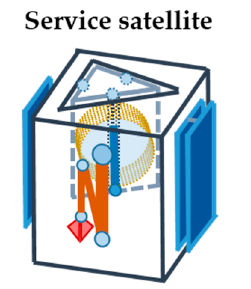
Figure 3. Diagram of service satellite folding state.